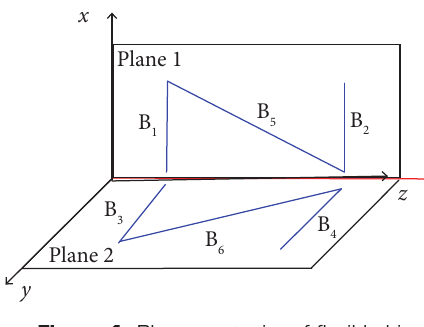
Figure 1. Plate-constraint of fl exible hinge.